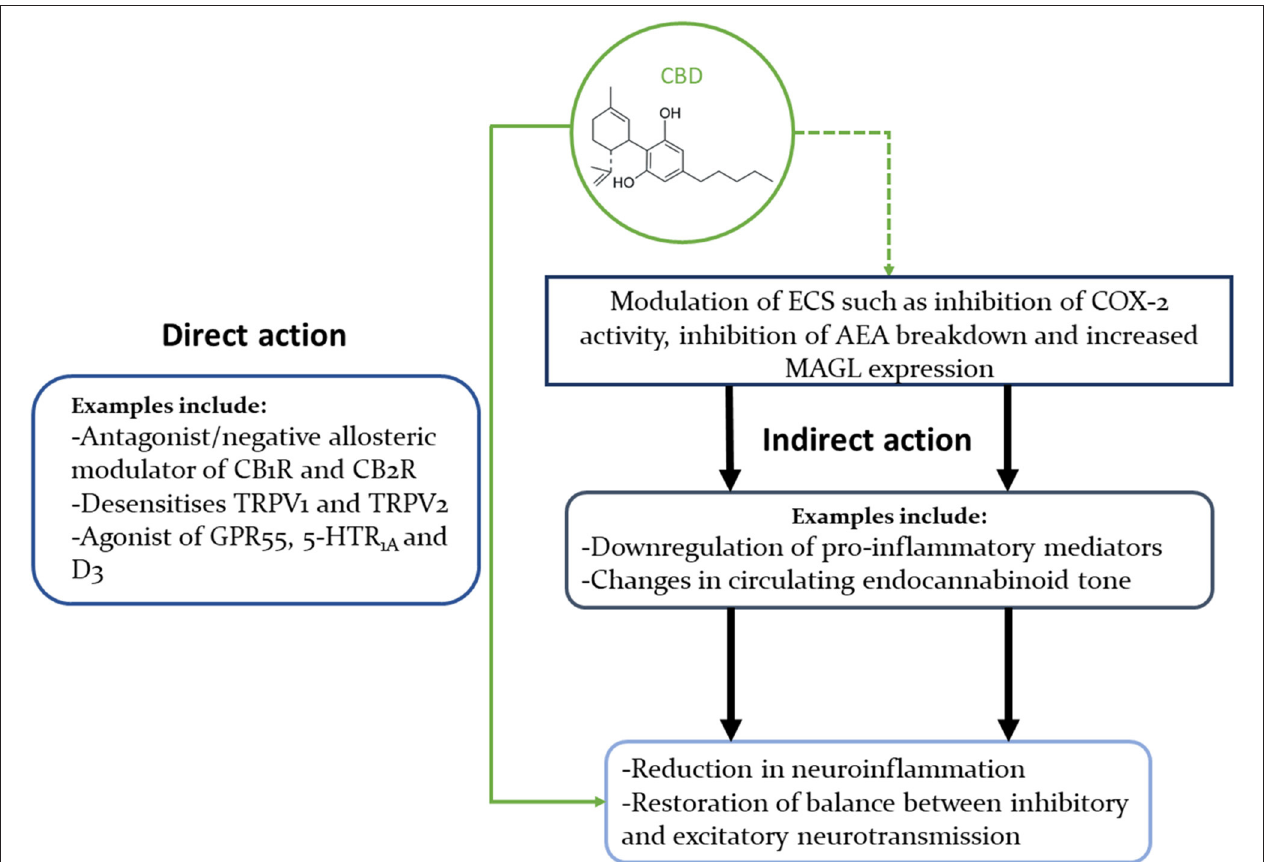
FIGURE 1 | Concise illustration of CBD’s interactions with multiple signalling pathways that could explain its beneficial effects in neuropsychiatric disorders. This diagram highlights the fact that CBD can modulate the ECS in multiple ways, as well as interact directly with many neural receptors (only some of which are shown in this